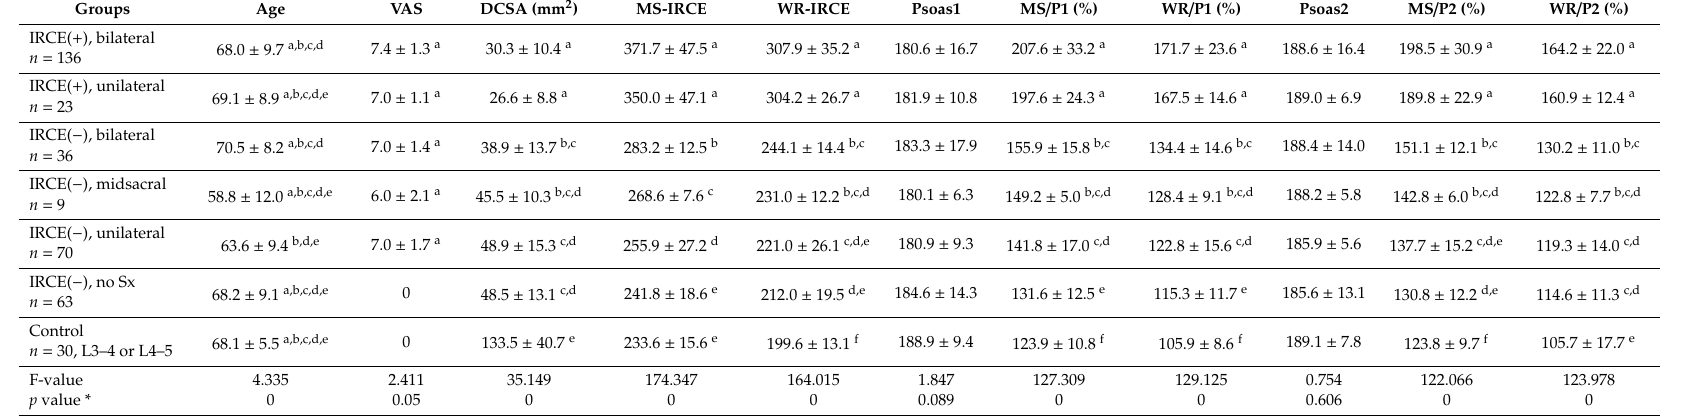
*—statisticalsignificancestestedbyone-wayanalysisofvariancesamonggroups. a,b,c,d,e,f —samelettersindicatestatisticallyinsignificantdi ff erencebetweengroupsbasedonGames-Howell’s